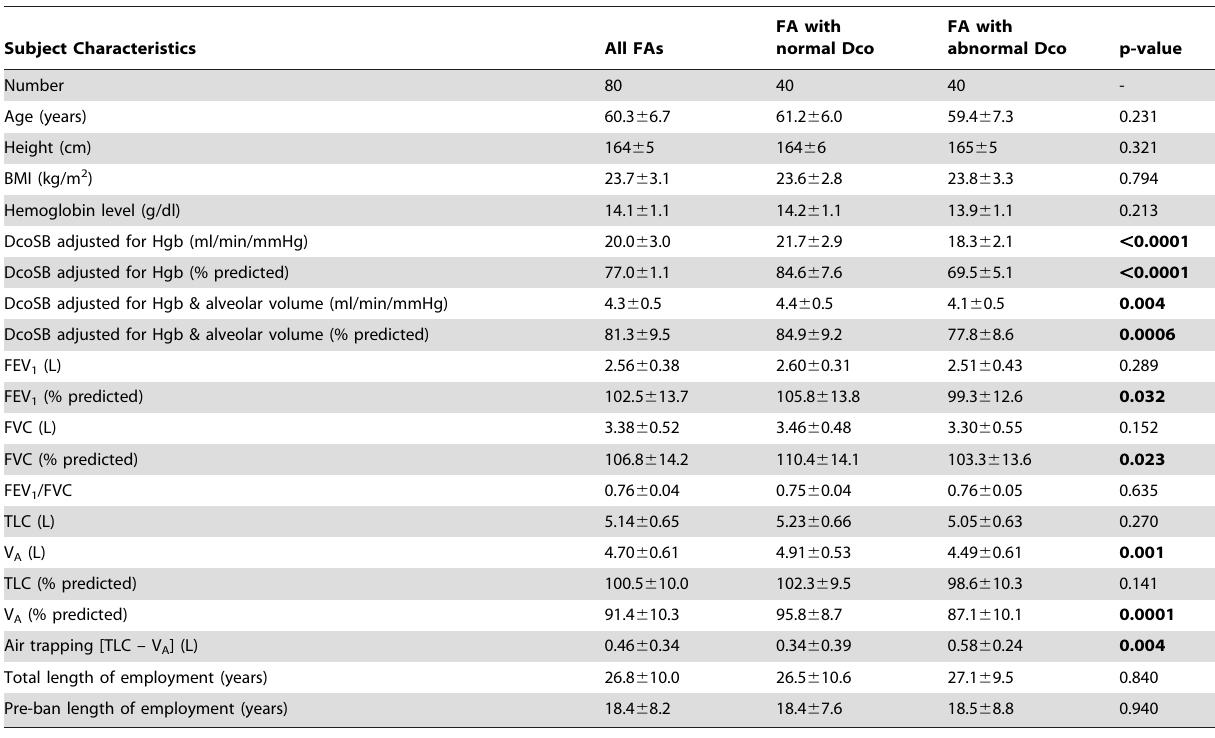
Table 1. Characteristics of pre-ban flight attendants.